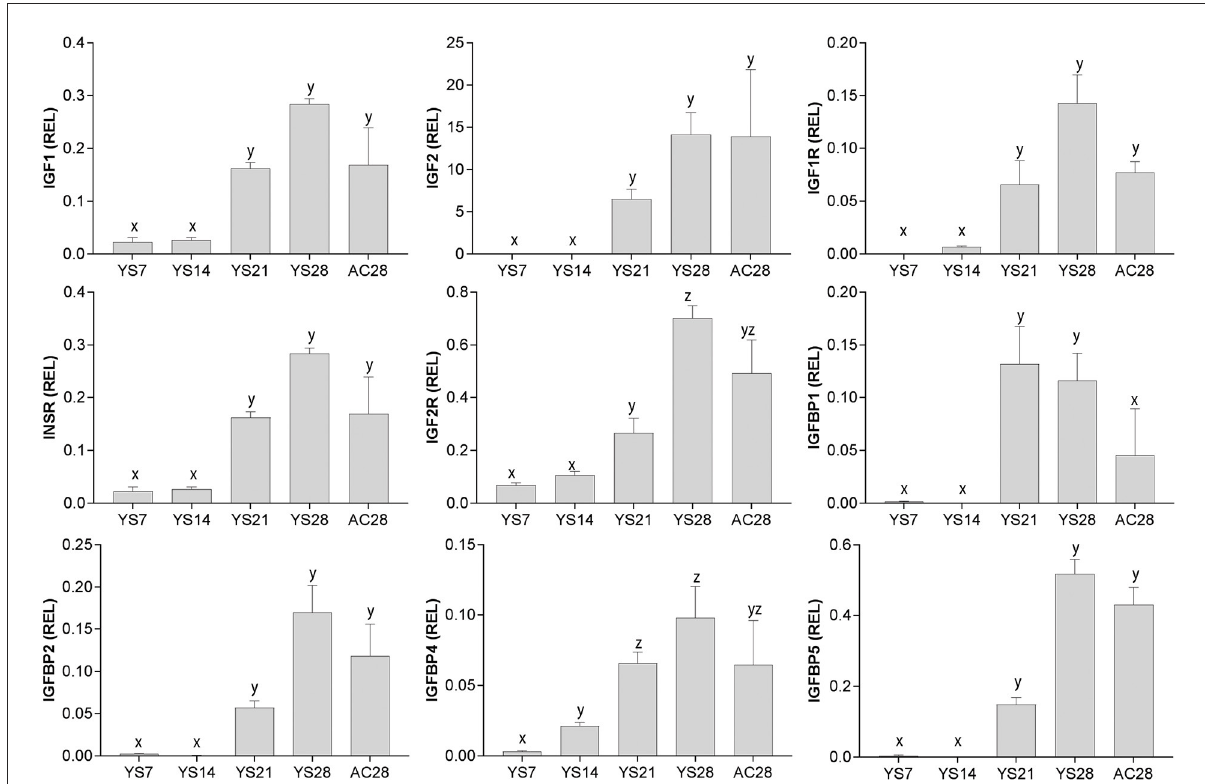
FIGURE2 Relative gene expression (mean ± s.e.m) for IGF1 , IGF2 , IGF1R , INSR , IGF2R , IGFBP1 , IGFBP2 , IGFBP4 and IGFBP5 in equine conceptus membranes (yolk sac: YS; allantochorion: AC) on different days of pregnancy. Values are calculated as the ratio of the target gene mean value to the geometric mean for the reference genes GAPDH , HPRT1, PGK1 and SRP14 . Significant differences between pregnancy stages are denoted by different superscripts (x, y, z; P <